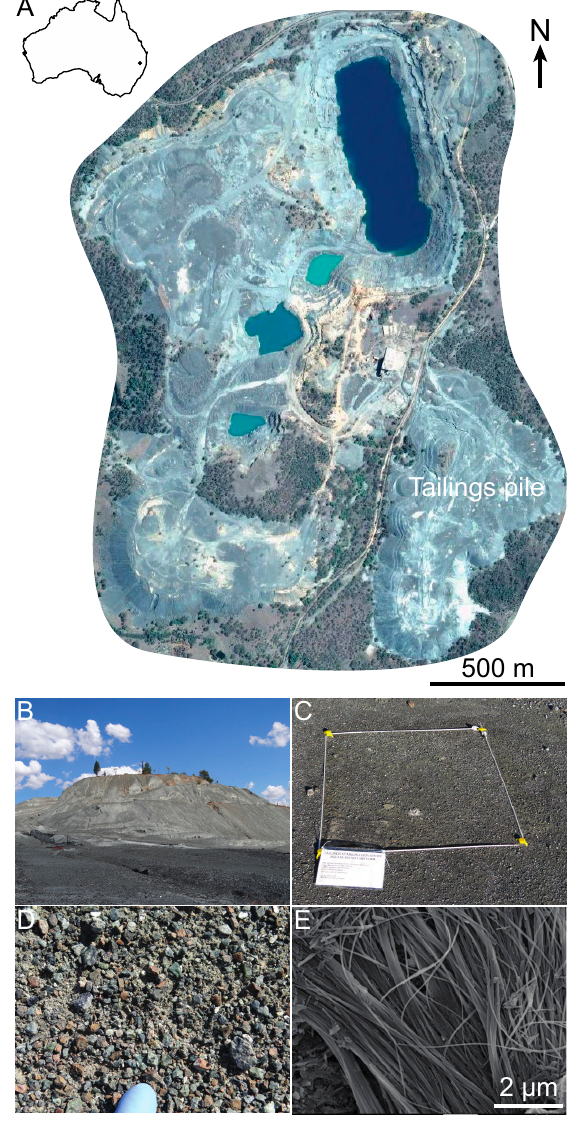
Figure 1. ( A ) Aerial view of Woodsreef Asbestos Mine, New South Wales, Australia (inset) showing the location of the tailings pile. ( B ) Woodsreef mine hosts 24 million t of asbestos tailings. ( C ) One of the 1 m × 1 m plots used to study acid dissolution and carbonation of mine tailings. ( D ) Sub-cm clasts, primarily serpentinite, cover the surface of the tailings pile. ( E ) Serpentine, including fibrous chrysotile, makes up 90 wt % of the tailings.